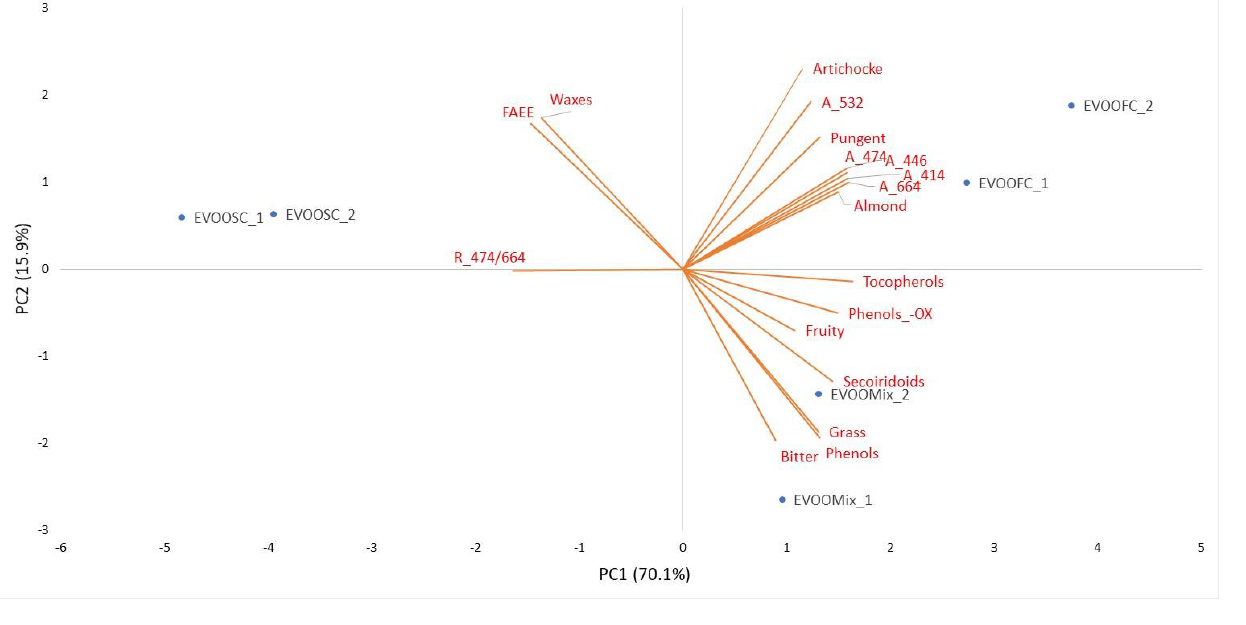
Figure 4. Biplot of the PCA conducted on of some chemical-physical, chemical analyses and the sensory profile attributes. sensory profile